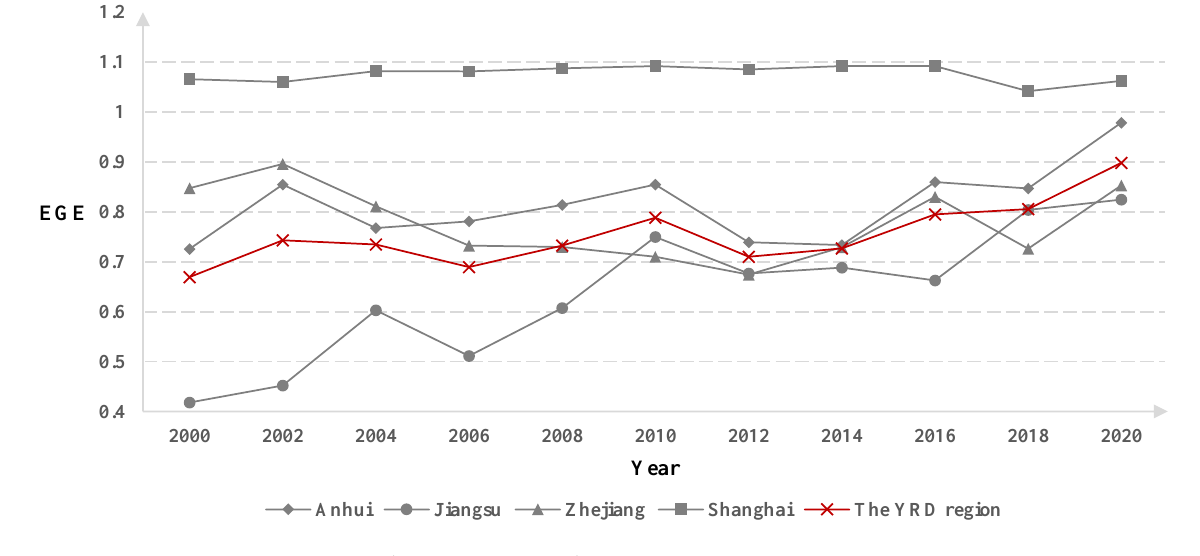
Figure 3. Changes in EGE in the YRD region. Table 3. Moran’s I indices of EGC and ER in the YRD